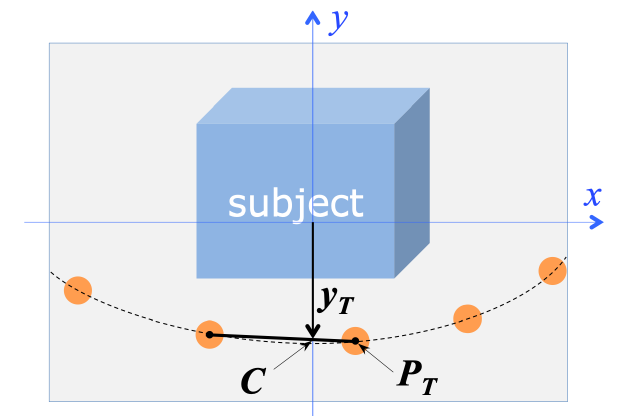
Figure 6. Acquisition geometry: estimation of the horizontal camera-trajectory distance D T , from the analysis of the camera